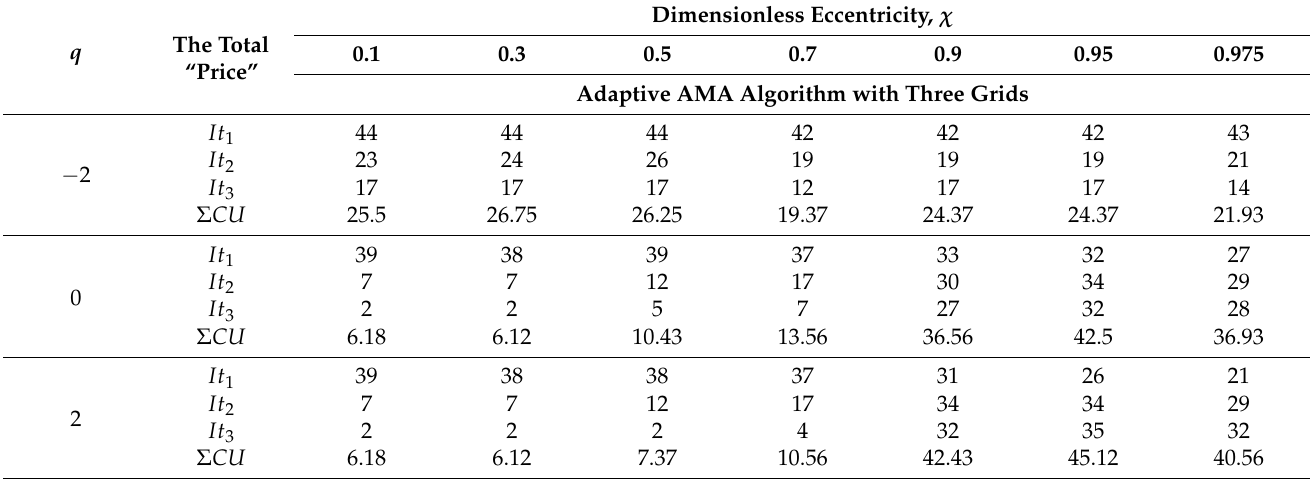
Table 2. Comparison of the efficiency of algorithms for solving the Reynolds equation.